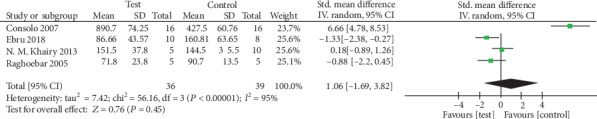
The bone density by radiological analysis.